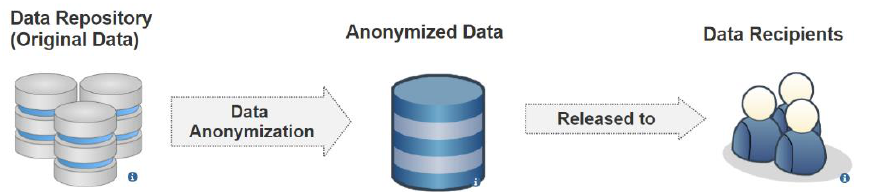
Fig. 2 . Data anonymization